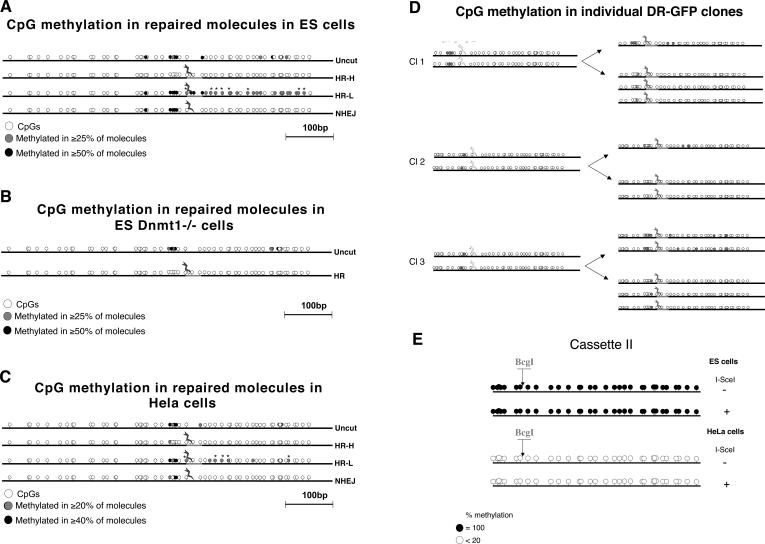
DNA Methylation in Repaired DNA Molecules(A) CpG methylation in repaired molecules from ES cells is shown. DNA molecules derived from pooled ES DR-GFP cultures transfected with the I-SceI expression vector or a control plasmid were subjected to bisulfite analysis (Materials and Methods). The number of molecules in each class was as follows: (1) uncut, 40 from cells transfected with control plasmid; (2) HR-H, 25 homologous recombinant molecules from high expressor cells sorted by FACS (23) or picked randomly from mass culture; (3) HR-L, 30 recombinant molecules from low expressor cells sorted by FACS (28) or picked randomly from mass cultures; (4) molecules rearranged at the I-SceI site (NHEJ). The frequency (%) of each class was derived from several independent experiments with mass culture and fluorescent-sorted cells. HR-H 3 ± 0.5; HL 3 ± 1; NHEJ 2 ± 0.3. All CpGs (white circles) flanking the I-SceI site are shown. Gray circles, CpGs methylated in ≥25% of molecules; black circles, CpGs methylated in ≥50% of molecules.(B) CpG methylation in repaired molecules in ES Dnmt1−/− cells is shown. DNA molecules were isolated from ES Dnmt1−/− cells carrying DR-GFP, 16 from control cells and 40 from cells exposed to I-SceI. The frequency of GFP+ cells was 5 ± 1.(C) CpG methylation in repaired molecules from Hela cells is shown. DNA molecules, derived from pooled Hela DR-GFP cultures transfected with the I-SceI expression vector or a control plasmid, were subjected to bisulfite analysis (Materials and Methods). The number of molecules in each class was as follows: (1) 25 molecules from cells transfected with control plasmid; (2) 20 recombinant molecules from low expressor cells sorted by FACS; (3) 15 recombinant molecules from high expressor cells sorted by FACS; (4) six molecules rearranged at the I-SceI site (NHEJ). The frequency (%) of each class was derived from several independent experiments with mass culture and fluorescence sorted cells. HR-H 2 + 0.5; HR-L 2 + 1; NHEJ 2 + 0.4. All CpGs (white circles) flanking the I–SceI site are shown. Gray circles, molecules methylated in ≥20% of molecules; black circles, molecules methylated in ≥40% of molecules.(D) CpG methylation in repaired molecules derived from individual DR-GFP clones is shown. DNA molecules were derived from clones 1, 2, and 3 of Figure 2. DNA was isolated and subjected to bisulfite analysis (Materials and Methods). Shown on the left are nonrecombinant molecules amplified with the 5′-unrec primer (see Figure 1). Shown on the right are recombinant DNA molecules isolated from cells transfected for 4 d with the I-SceI expression vector and selected for GFP expression. The arrows indicate hypermethylated DNA from clones expressing GFP at low levels and hypomethylated DNA from high GFP expressors.(E) Methylation of GFP cassette II is not influenced by recombination. DNA methylation pattern of cassette II in Hela DR-GFP (25 molecules) and ES DR-GFP (30 molecules) cells after transfection with I-SceI or before transfection (seven molecules) is shown. The methylation pattern of cassette II was identical in FACS sorted ES or Hela cells.The molecules analyzed both in ES and Hela cells derived from at least five independent bisulfite reactions and ten independent PCRs for each group: (1) PSVβGal transfected cells; (2) GFP- and (3) GFP+ high, and (4) low expressors from I-SceI transfected cells.